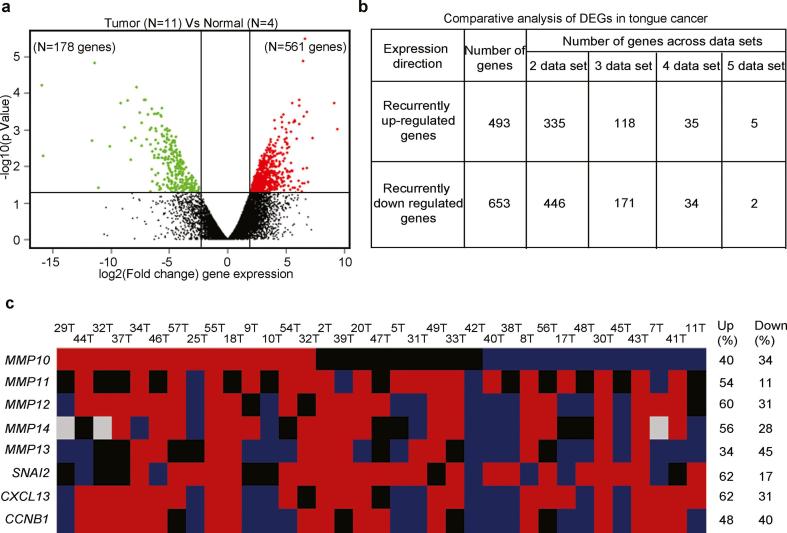
Differential expression profile of tongue squamous cell carcinoma using mRNA sequencing and meta-analysis identifies MMP10 up regulation. Differential expression analysis to identify the distinct gene expression profile of tongue tumors. (a) Volcano plot representation of differentially expressed in between early tongue tumors and adjacent normal tongue tissues. The red and green dots denote the up-regulated and down-regulated differentially expressed genes with P value <0.05 and fold changes ≥2 or ≤−2 for, respectively. (b) The tabular representation of a number of genes overlapped in tongue cancer across different studies. (c) Schematic representation of commonly up-regulated genes qRT-PCR validation in a cohort of 35 paired tongue tumor samples. The Red denotes up-regulation, blue as downregulation, black as basal expression and gray color; experiment could not be done or results could not be acquired. The ≥2 mean fold change is for up-regulation, ≤0.5 mean fold change for down-regulation and in between 1.99 and 0.501 mean fold change as a basal level expression compared to the adjacent normal tissue sample. (For interpretation of the references to color in this figure legend, the reader is referred to the web version of this article.)